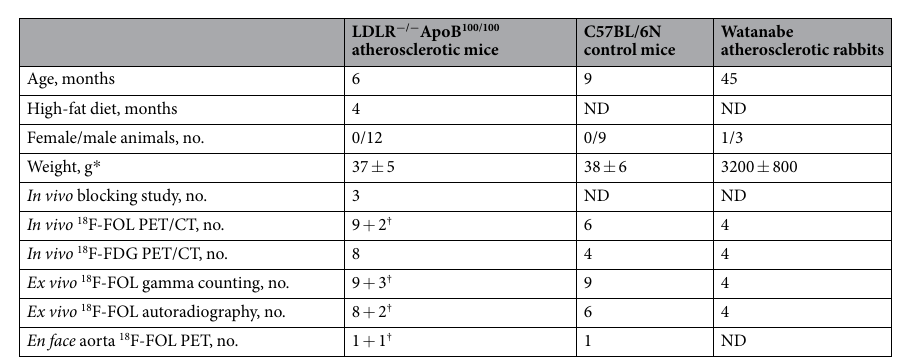
Table 1. Basic characteristics of investigated animals. LDLR − / − ApoB 100/100 = low-density lipoprotein receptor deficient mouse expressing only apolipoprotein B100; ND = not done; Blocking study = in vivo competition assay with 100-fold molar excess of folate glucosamine injected 1 min before 18 F-FOL; no = number of investigated animals. * Values are mean ± SD. † No. for blocking